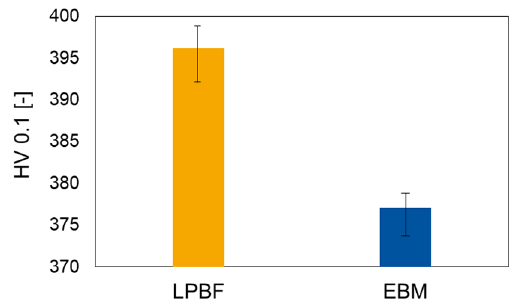
Figure 11. Hardness of LPBF and EBM cubes.